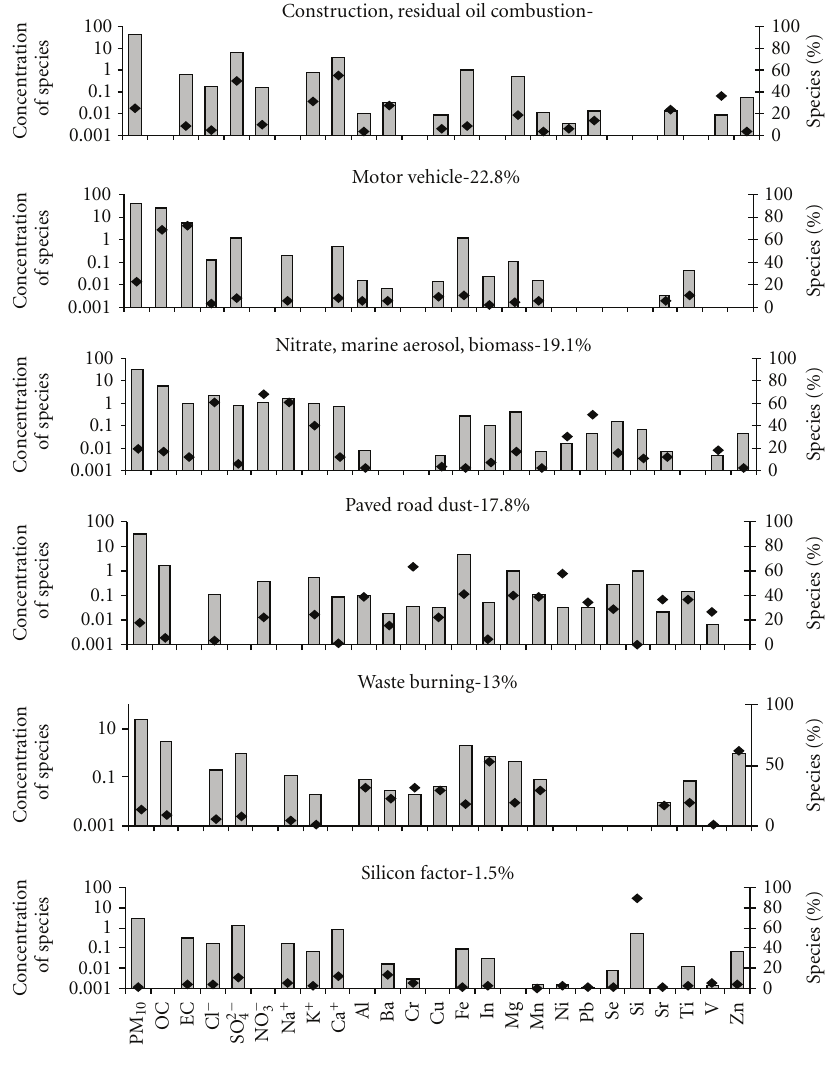
Figure 5: PMF factor profile for